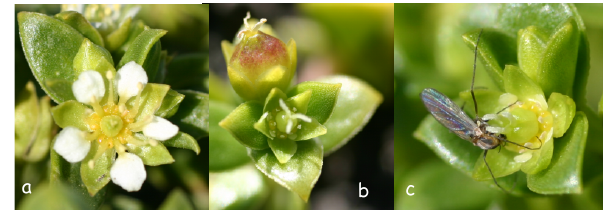
Figure 3. Honckenya peploides : (a) staminate flower, (b) pistillate flower and a capsule, (c) pistillate flower visited by Halocladius